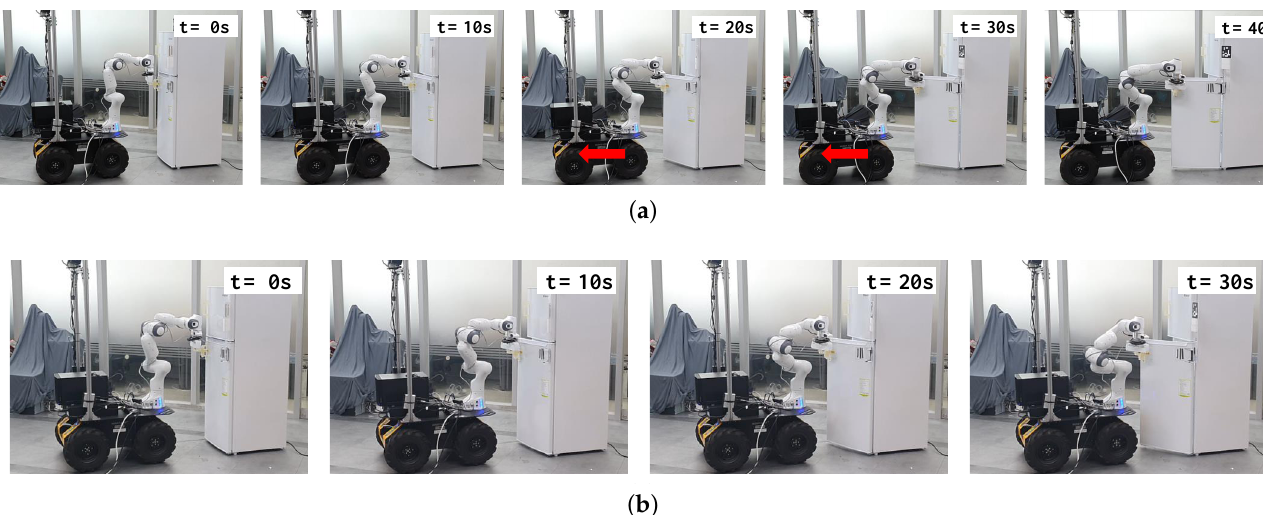
Figure 19. Experimental results of opening a refrigerator. ( a ) Snapshots of opening a refrigerator with obstacle avoidance; ( b ) snapshots of opening a refrigerator without obstacle